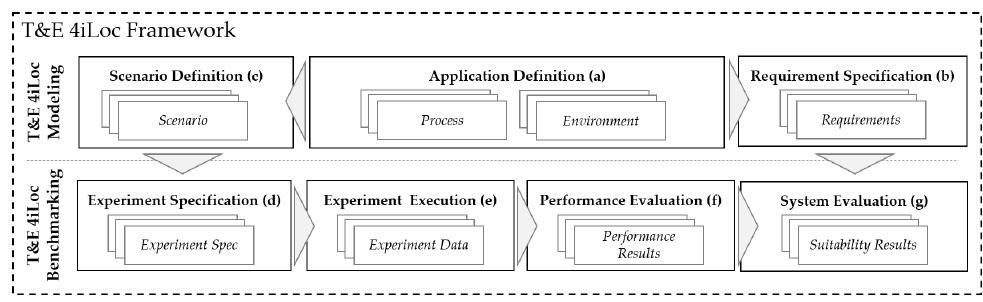
Figure 3. Architecture of the T&E 4iLoc Framework